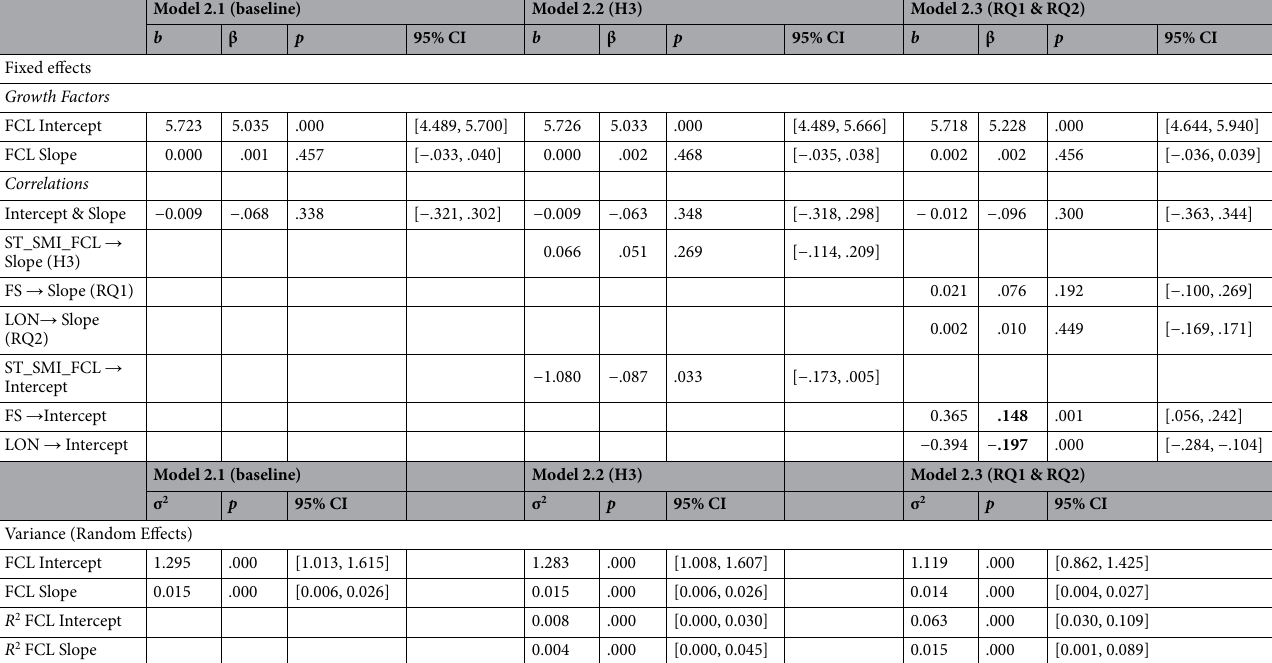
Table 3. Growth modelling results regarding the longer-term growth in friendship closeness (FCL) based on the follow-up assessments. ST_SMI_FCL = short-term social media-induced change in friendship closeness (obtained from M1.1); FS = Friendship Support; LON = Loneliness; b s are unstandardized; βs are standardized using the STDYX Standardization in Mplus; p -values are one-tailed Bayesian p -values 27 ; significant fixed effects are depicted in